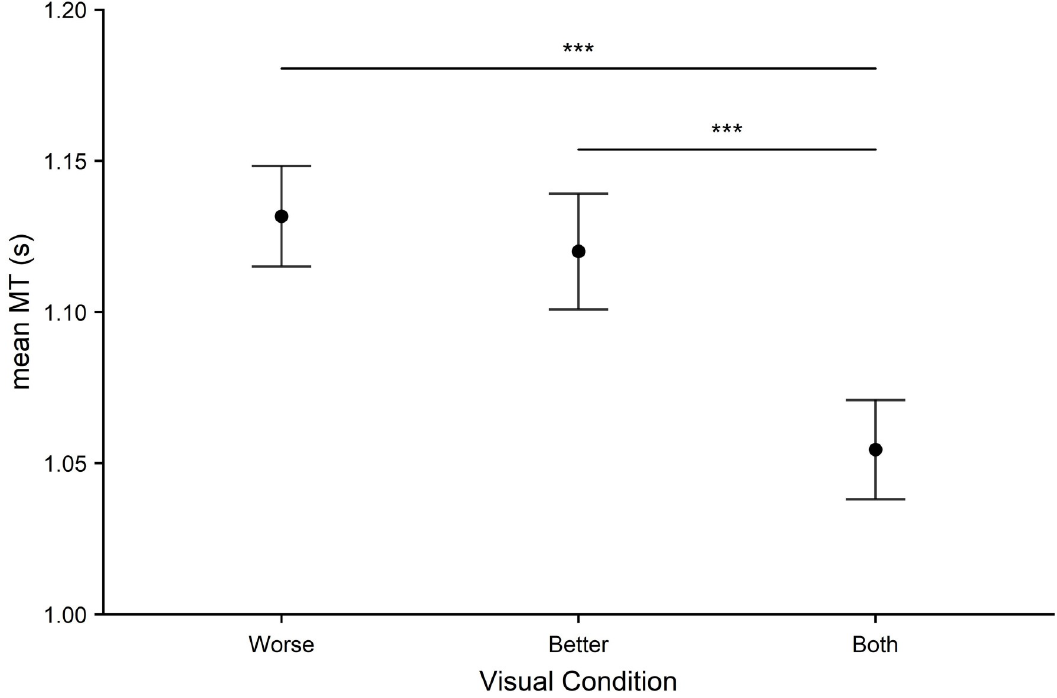
Fig 8. Aiming performance was measured using mean movement time (MT) in seconds across all visual conditions (worse eye, better eye, both eyes). Error bars represent the standard error of the mean. Significant effects are represented as: p < 0.05 ( � ), p < .01 ( �� ), p < .001 ( ���